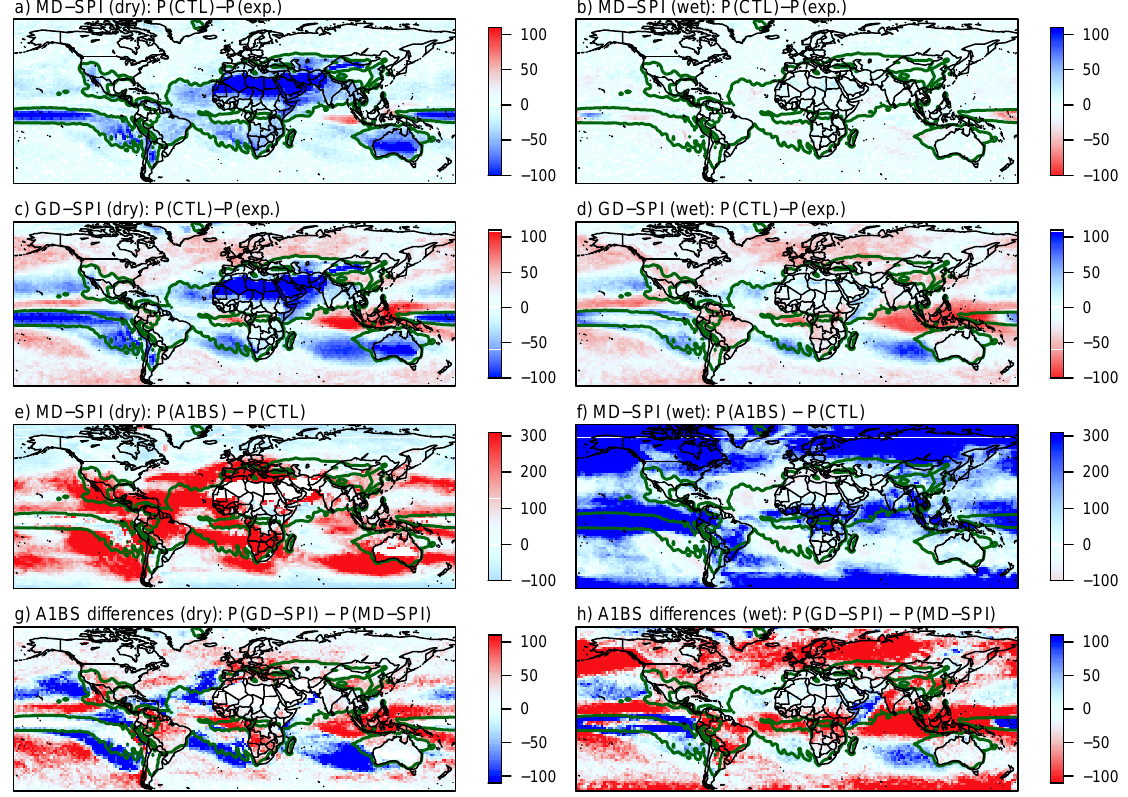
Fig. 14. Comparison of SPI dry (left column) and wet (right column) extreme occurrences in the control (CTL) and stabilisation run (A1BS). (a–d) : differences to the expected probability ( P in %) of the extreme SPI classes ( P ≈ 2.3%) for CTL based on MD-SPI (a, b) and CTL based on GD-SPI (c, d) . MD-SPI probability changes in percent of extreme dry (e) and wet (f) conditions in respect to the CTL. (g, h) : SPI projection differences between GD-SPI and MD-SPI. The green lines surround dry regions where the SPI lower bound is higher than − 2 for at least 1 month.